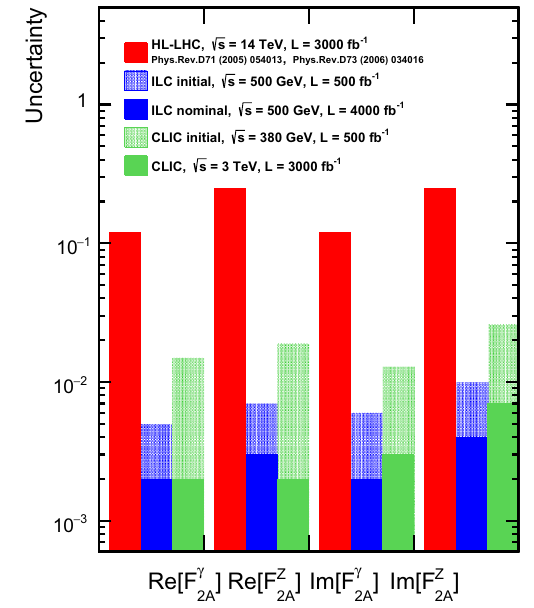
Fig. 6 Graphical comparison of 68% C.L. limits on CP-violating form factors expected at the LHC [82,83], and at the ILC and CLIC (this work). The LHC simulations assume an integrated luminosity of L = 3000fb − 1 at 14 TeV. For the ILC we assume an initial L = 500fb − 1 at 500 GeV and a beam polarization P e − = ± 0 . 8 , P e + = ∓ 0 . 3. The nominal scenario envisages an integrated luminosity of 4 ab − 1 . For CLIC we assume L = 500 fb − 1 at 380 GeV for the initial stage and L = 3000 ab − 1 at 3 TeV for the high-energy stage. The electron beam polarization is P e − = ± 0 . 8 and no positron polarization is envisaged and σ t ¯ t γ /σ t ¯ t may be calculated to approximately 3%